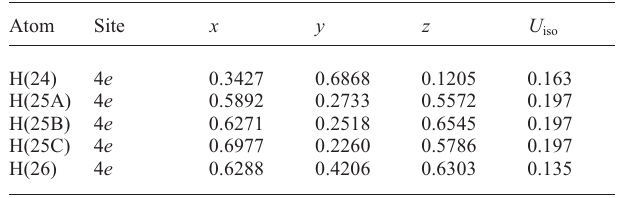
Table 3. Atomic coordinates and displacement parameters (in Å 2 )